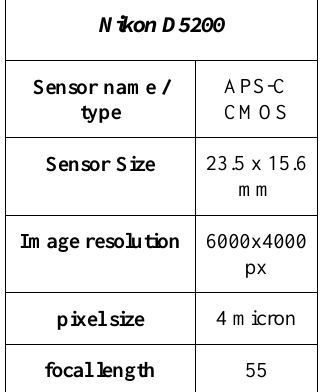
Table1: Main characteristic of the used camera.